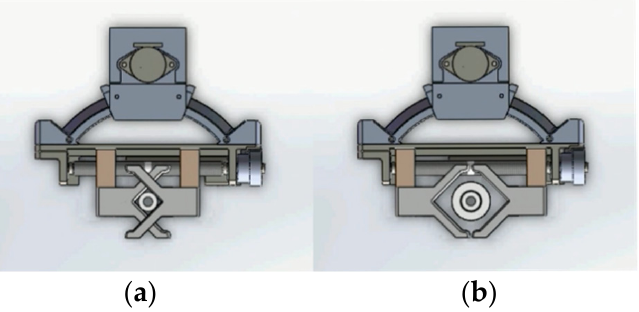
Figure 4. The working states of the double V-shaped grippers ( a ): clamping state; ( b ): loosening state. Advancement and rotation of the 5 Fr catheter were used to evaluate the